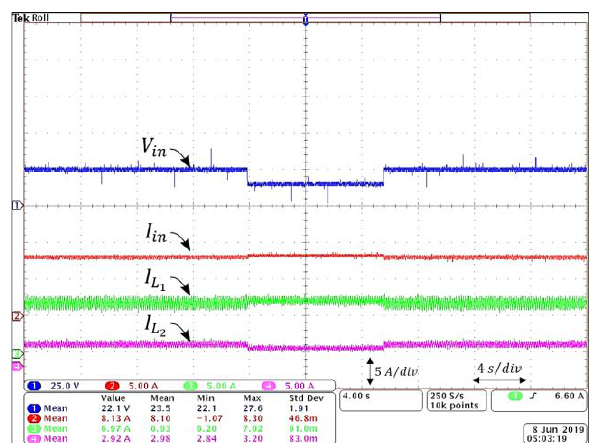
Figure 14. Dynamic compensation of the input current under variations in the input voltage.